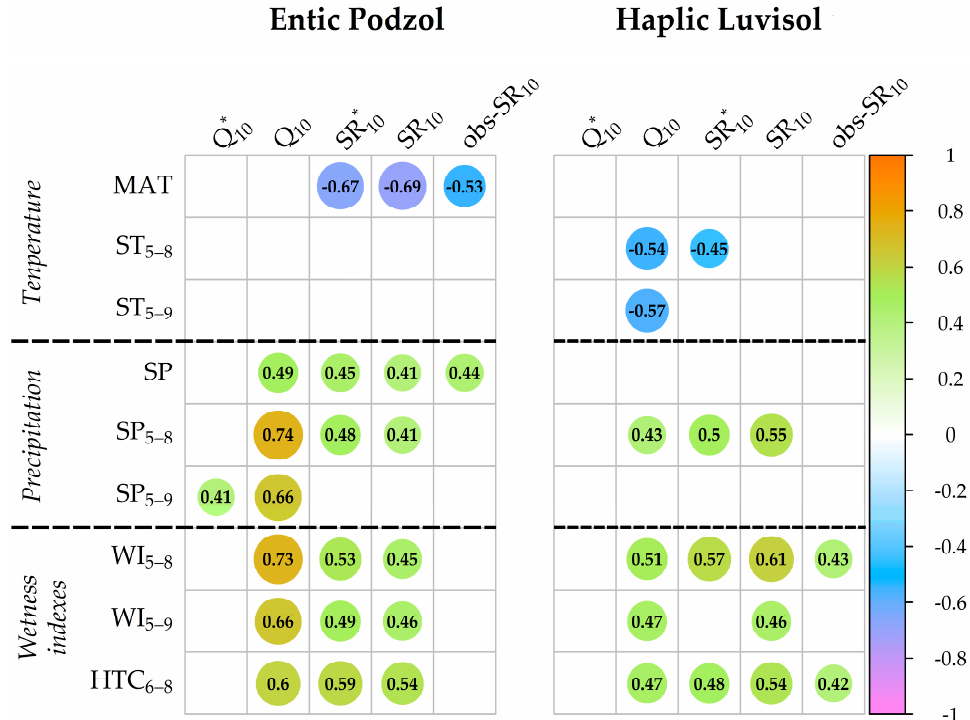
Figure 7. Correlations between Q* 10 , Q 10 , SR* 10 and SR 10 values and the meteorological indexes. Only the significant correlations are shown ( p < 0.05). Q* 10 and Q 10 are the temperature coefficients of the soil respiration at all ranges of the soil temperature, Ts, and for Ts ≥ 1 ◦ C, respectively; SR* 10 and SR 10 are the rates of soil respiration at 10 ◦ C (gCm − 2 day − 1 ) calculated using Q* 10 and Q 10 . Obs-SR 10 is the observation SR value at Ts = 10 ◦ C. Meteorological indexes: SP is the annual sum of precipitation (mm); SP 5–8 and SP 5–9 are the sums of monthly precipitation from May to August and May to September, respectively; WI 5–8 and WI 5–9 are the wetness indexes from May to August and May to September, respectively; HTC 6–8 is the hydrothermal coefficient over the summer period